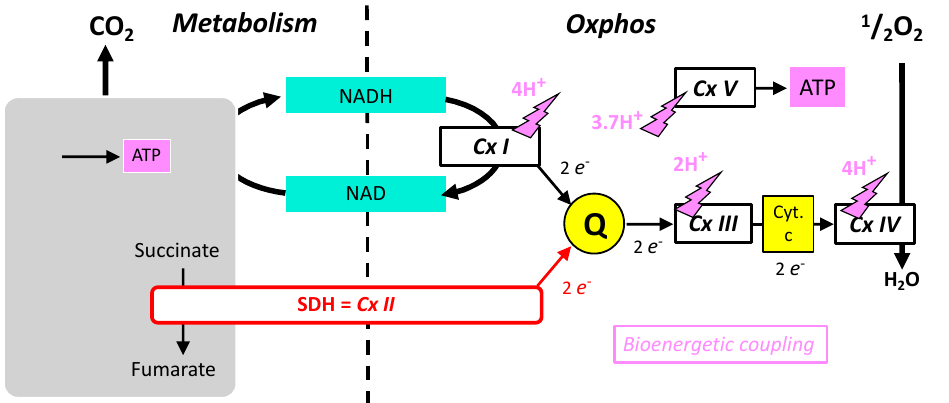
Figure 2. Schematic representation of the role of SDH and its relationships with oxidative metabolism (Metabolism), shown as a grey box releasing CO 2 and producing some ATP and oxidative phosphorylation with the five complexes (CxI-V) and redox shuttles (NAD/NADH) quinone (Q) and cytochrome-c.